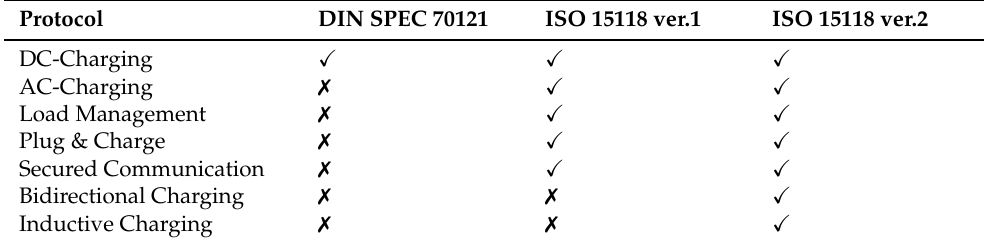
Table 2. Functional Differences between CCS-Communication Protocols.